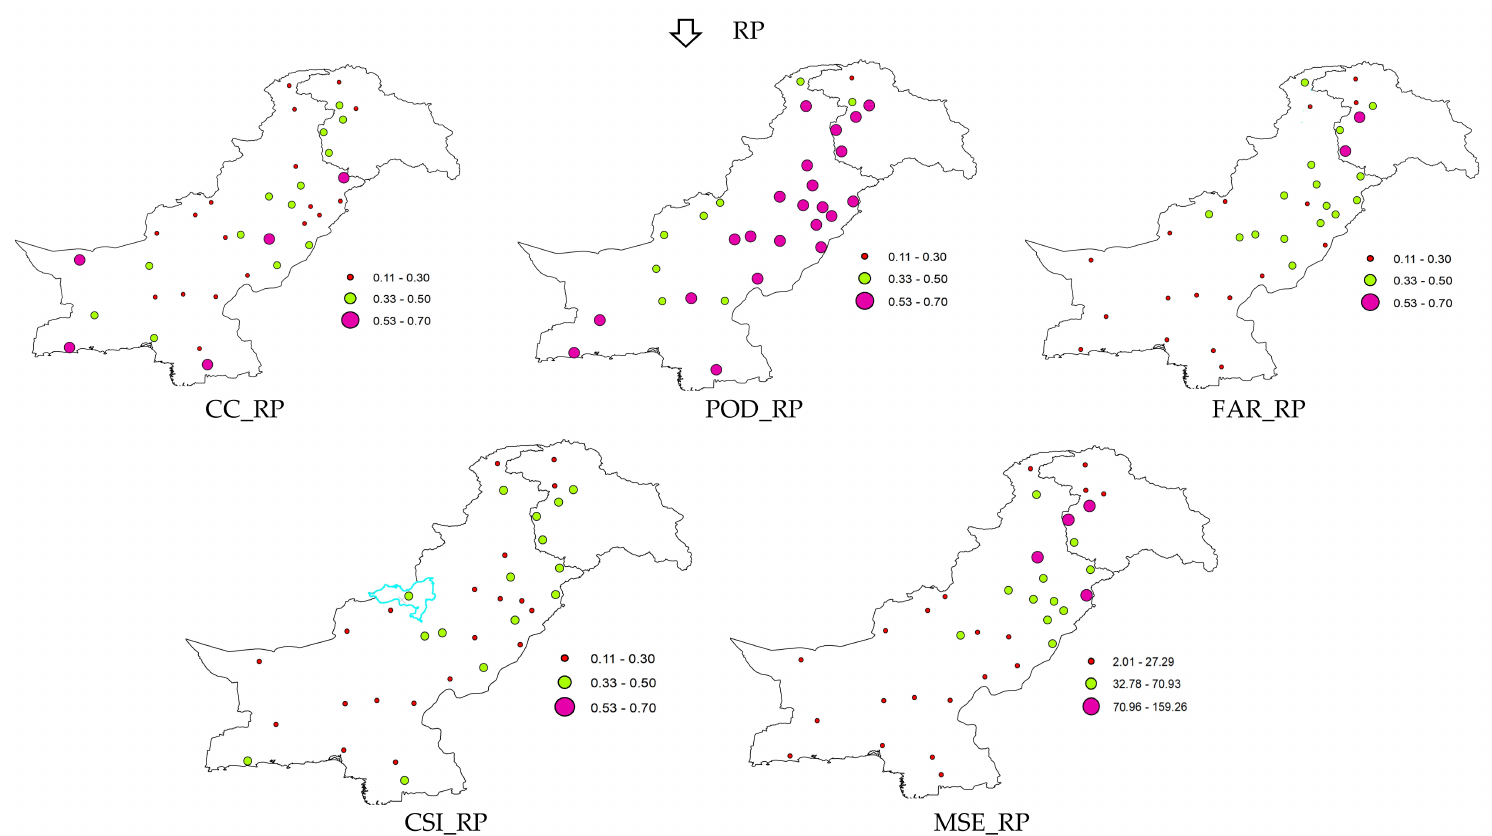
Figure 3. Spatial distribution of the selected metrics (i.e., correlation coefficient (CC), probability of detection (POD), False alarm ratio (FAR) and Critical success index (CSI) and mean square error (MSE) (in mm 2 )) for the IMERG research (IR), IMERG real-time (IT) and TRMM 3B42 (TR) and regional precipitation (RP) over Pakistan (Note: above RP: Column shows Satellite Product, while row indicating metrics, below RP: distribution of all metrics for the RP